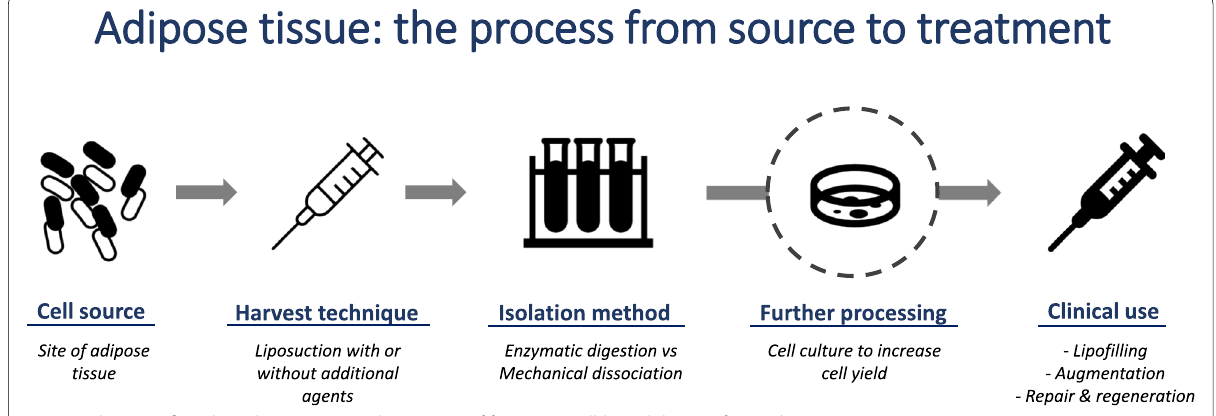
Fig. 1 Schematic flowchart demonstrating the process of forming a cell-based therapy from adipose